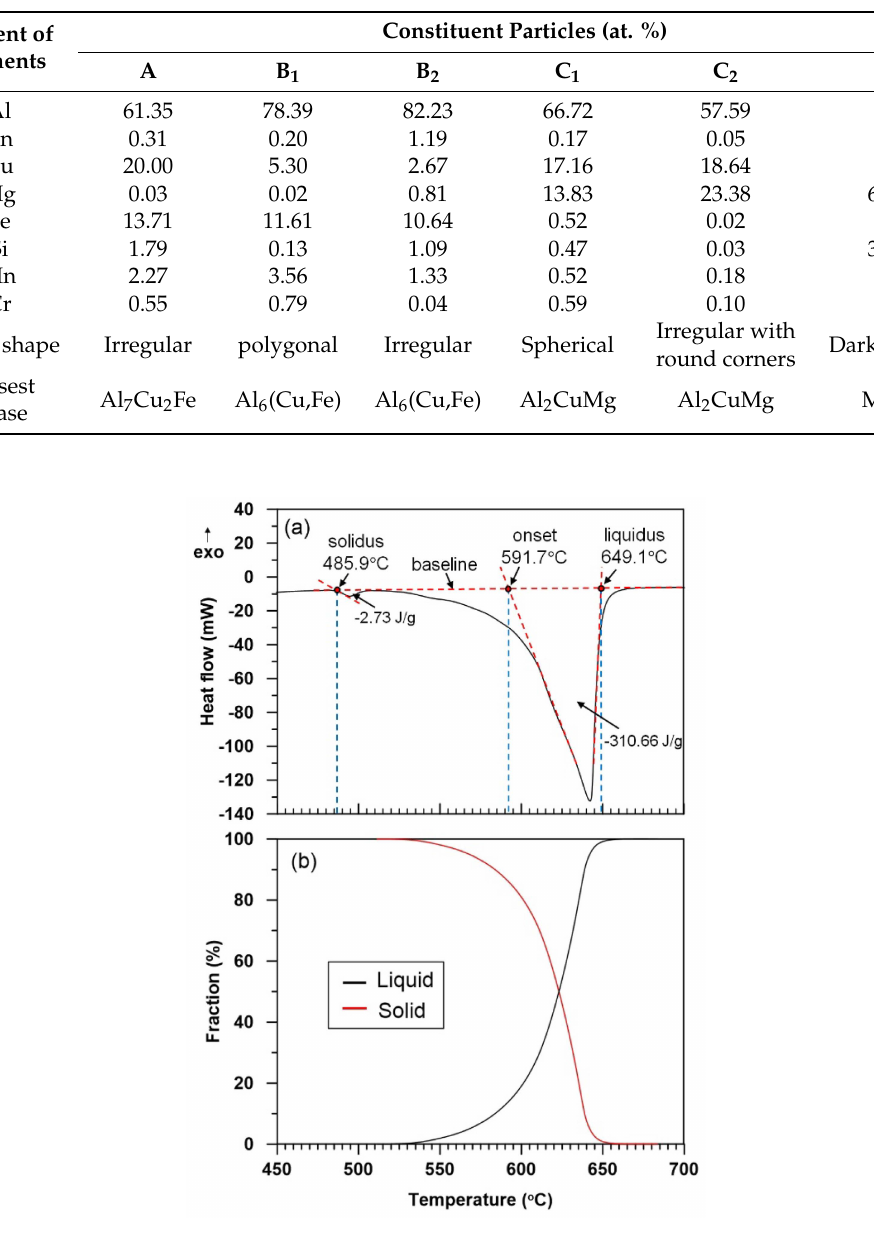
Figure 2. ( a ) Differential scanning calorimeter (DSC) curve of 7075 Al alloy at a heating rate of 10 ˝ C/min; ( b ) solid and liquid volume fraction versus temperature derived from the DSC